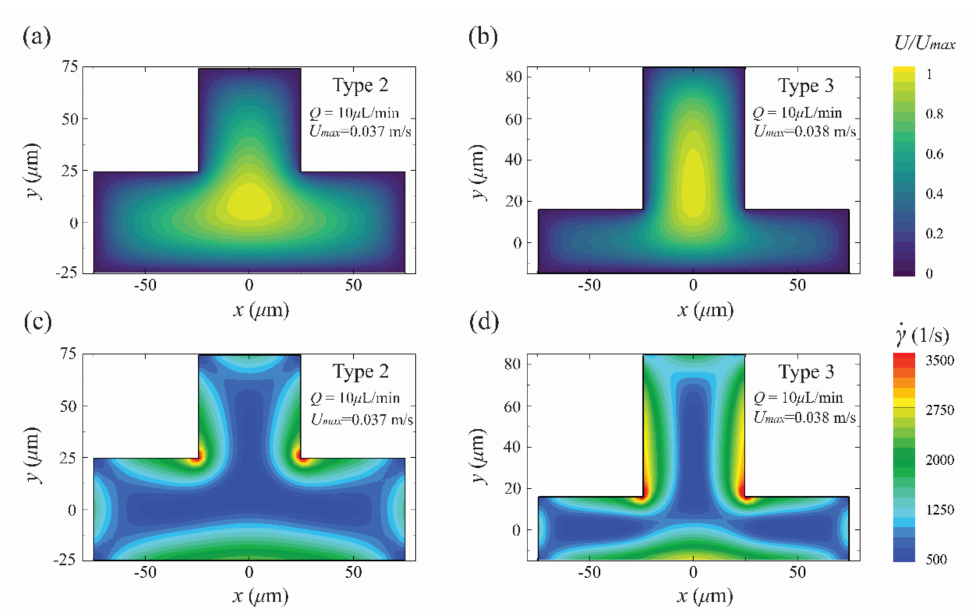
Figure 8. Simulation results of the ( a , b ) axial velocity magnitude U , normalized by the maximum axial velocity U max , for Type 2 and Type 3 channels, and ( c , d ) shear rate, channels at the flow rate of 10 µ